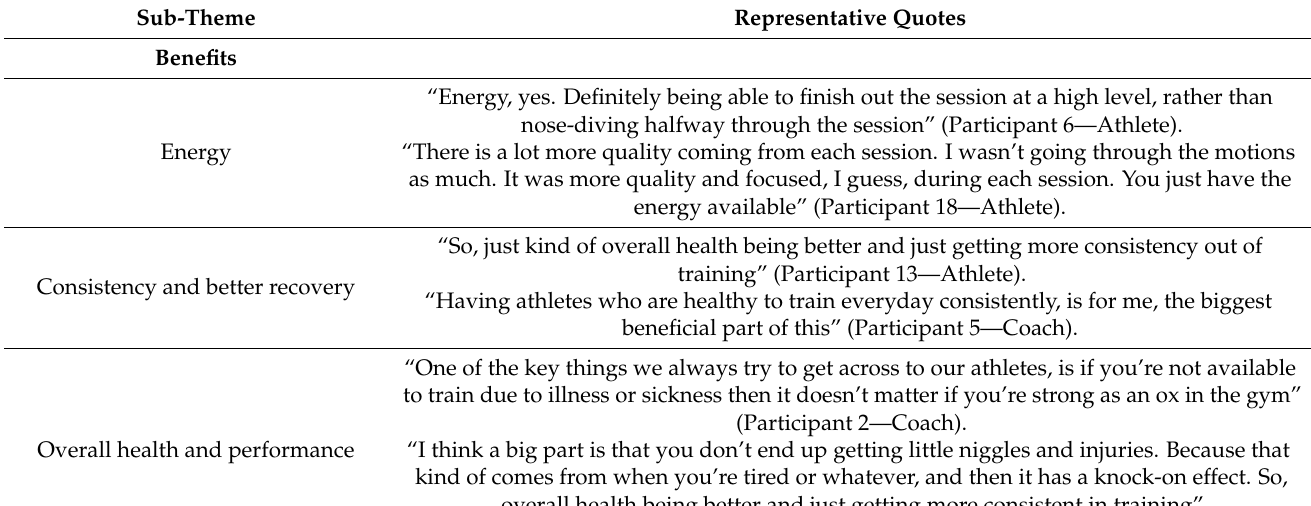
Table 3. Theme: The benefits and challenges of adequate